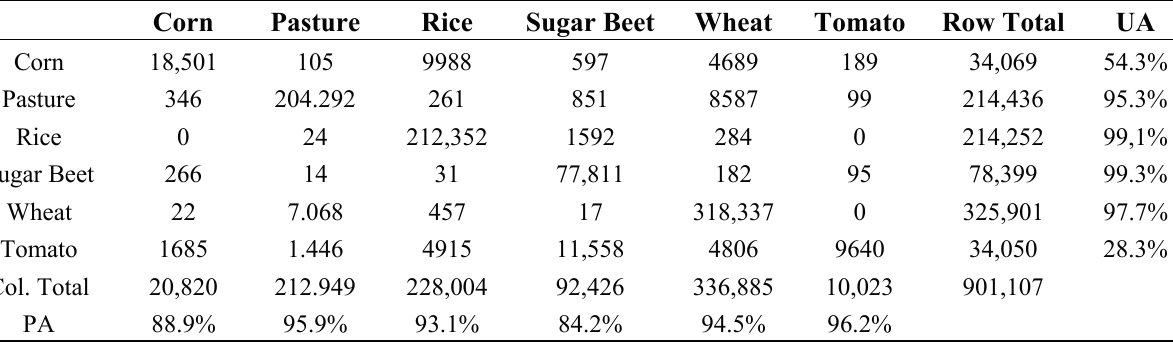
Figure 8. ( a ) Kompsat-2 July test image (RGB, 2,721 × 2,258 pixels, acquired on 11 July 2008), and the ( b ) reference map. Thematic output maps of, ( c ) SVM without smoothing, ( d ) SVM-LCS, ( e ) SVM-ECS, and ( f ) parcel-based strategy with SVM without smoothing. Table 2. Confusion matrix of SVM-ECS classification for Kompsat-2 July test image. Corn Pasture Rice Sugar Beet Wheat Tomato Row Total